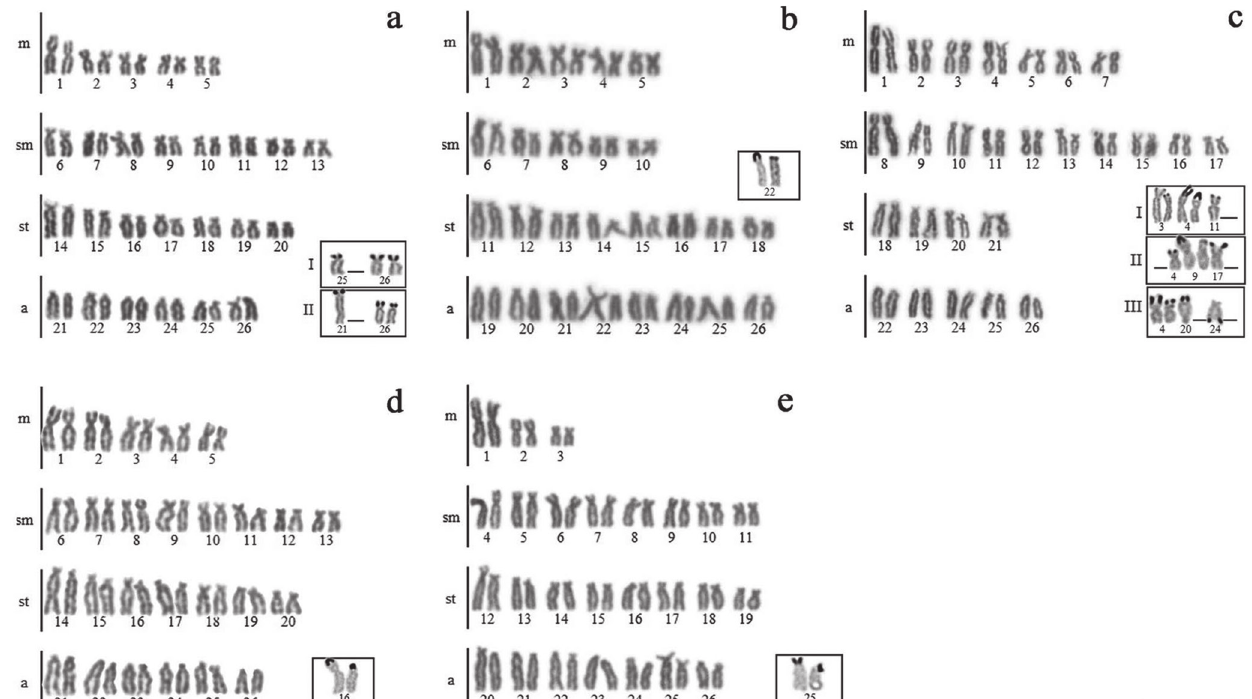
Fig. 1. Karyotypes arranged from Giemsa-stained chromosomes. Pairs of the AgNORs are in the boxes. a. Bryconamericus aff. iheringii (Ijuí River) - box I: pattern I; box II: pattern II; b. B. aff. iheringii (Iguaçu River); c. B. coeruleus - box I: pattern I; box II: pattern II; box III: pattern III; d. B. cf. ecai ; e. B. cf. eigenmanni . Scales bar = 10